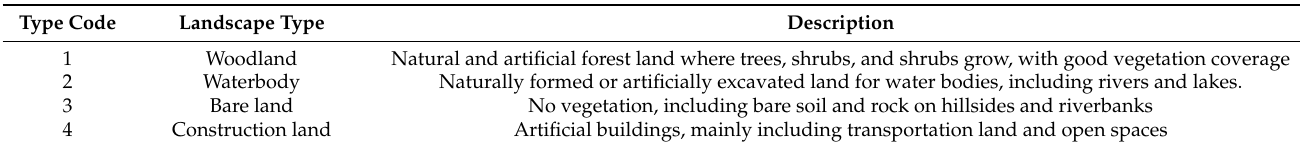
Table 2. Landscape classification system and